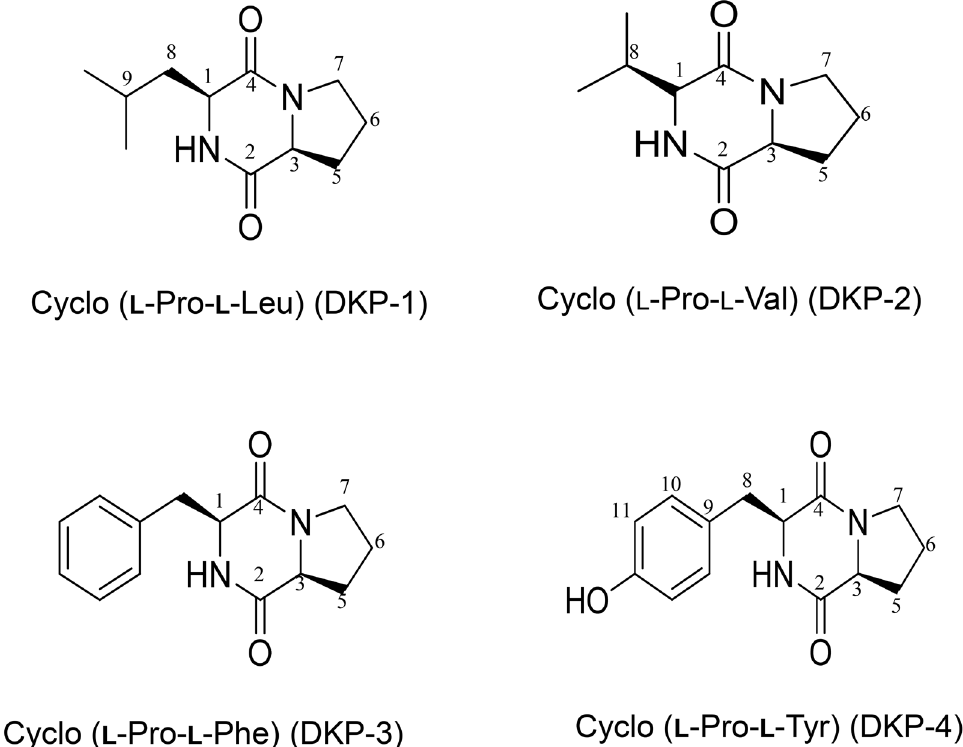
Figure 1. Structures of isolated cyclic dipeptides from the ethyl acetate extract in the cell-free filtrate of E. acetylicum S01. Chemical structures of the four cyclic dipeptides identified from E. acetylicum S01.